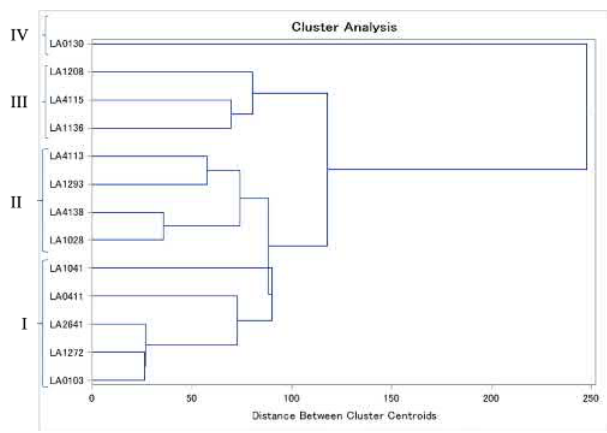
Figure 1. Dendrogram of 13 wild tomato accessions based ona- gronomic traits, nutritional and physicochemical parameters generated by centroid hierarchical cluster